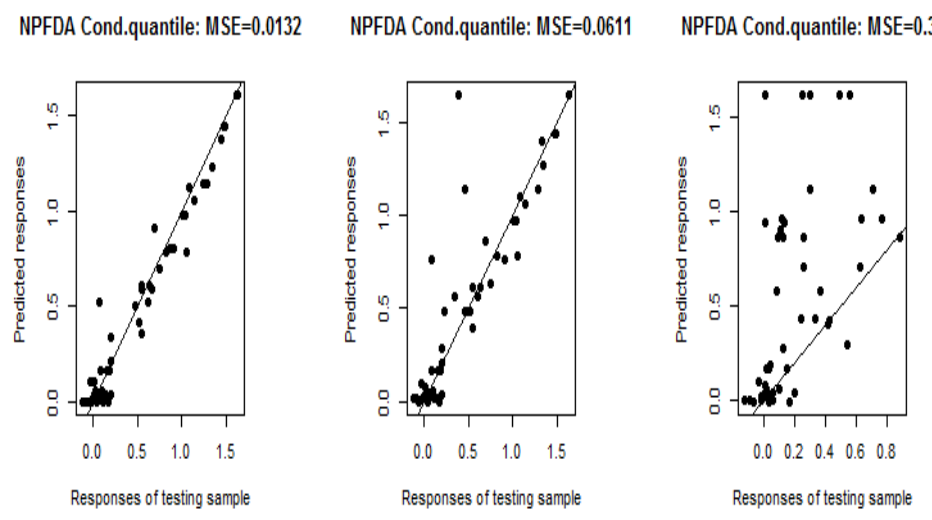
Figure 12: CR ∼ 3.5% , MSE=0.0132 on the left, CR ∼ 18% , MSE=0.0611 on the center, and CR ∼ 48% , MSE=0.3214 on the right